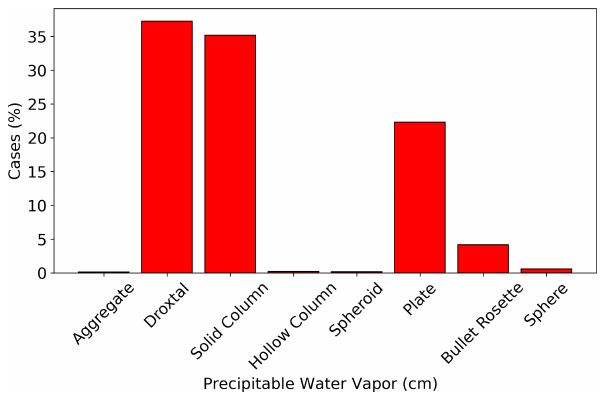
Figure 9. Percentage of retrievals for each ice particle shape. Most particles are modeled as droxtals (37%), solid columns (35%), plates (22%) and bullet rosettes